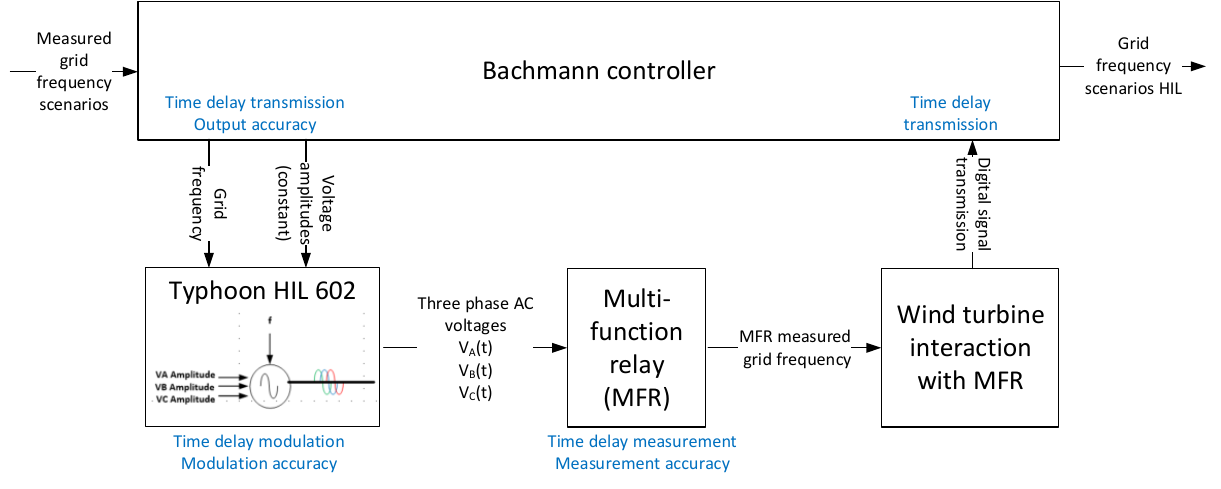
Figure 7. Measurement setup of the HiL tests and indication of the occuring accuracy issues and time delays.